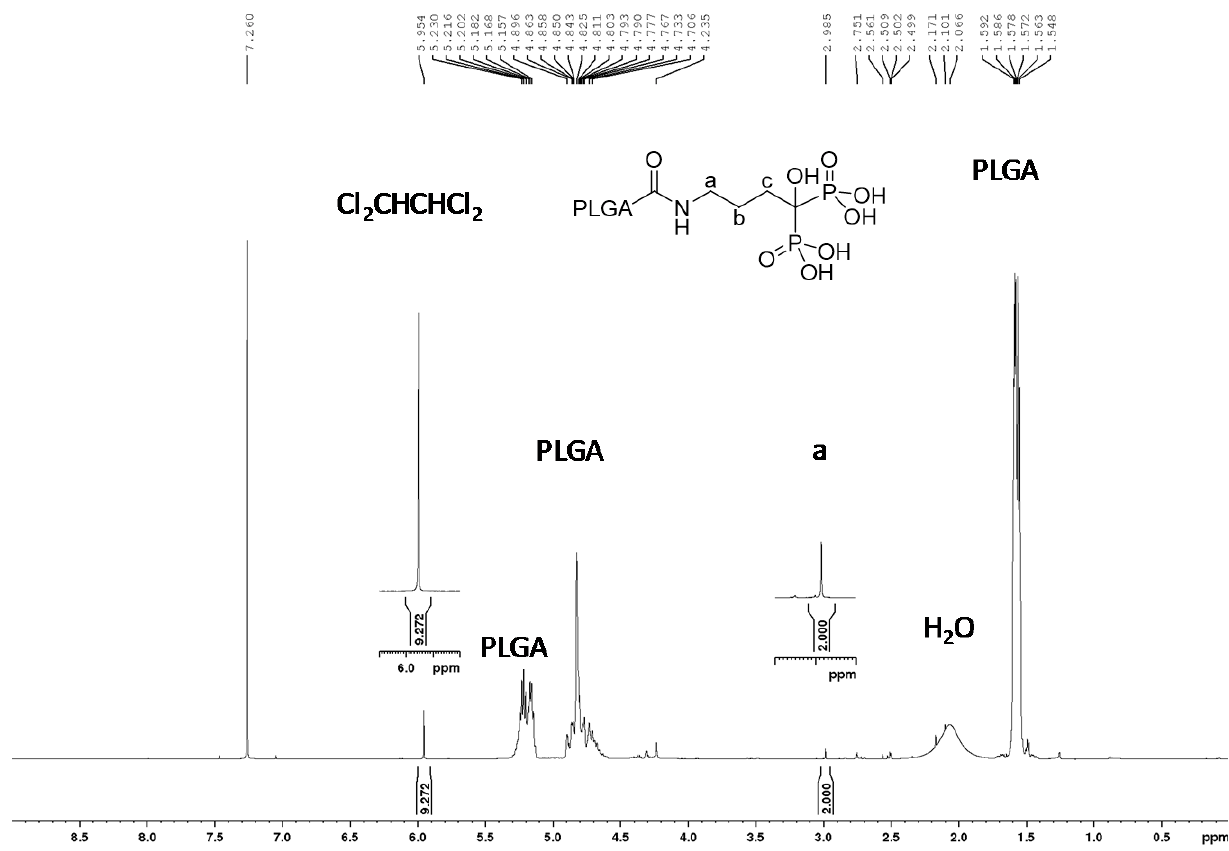
Figure 1. 1H-NMR spectrum of electrospun meshes soaked using Cl2CHCHCl2 as internal standard to quantify the amount of PLGA-ALD. The signal at 7.26 ppm corresponds to the solvent signal CHCl3.